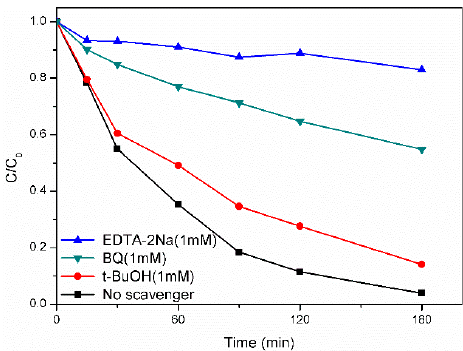
Figure 9. Photodegradation of MO over AFO-6 under visible light irradiation with addition of different trapping agents.